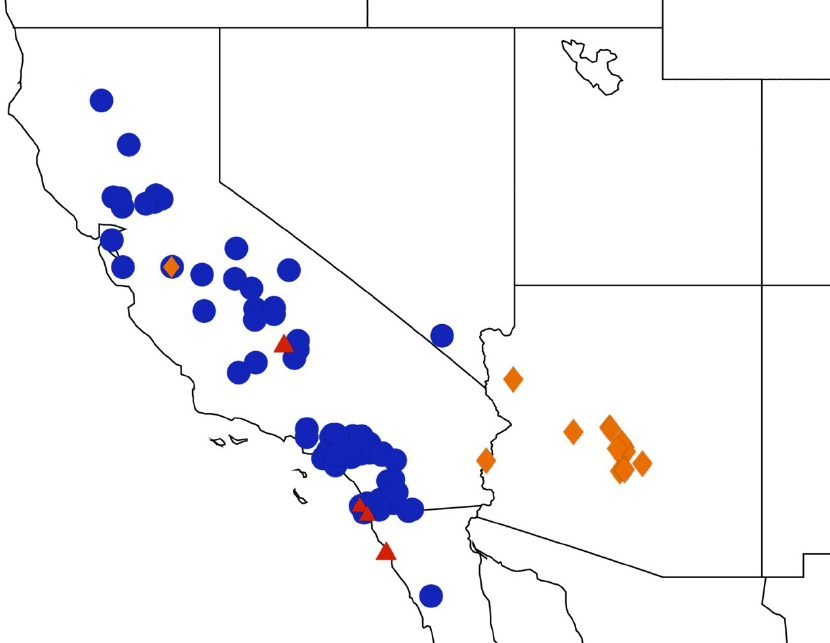
Figure 44. Distribution of Clidophleps distanti distanti (blue circles), C. distanti truncata (red triangles) and C. rotundifrons (orange